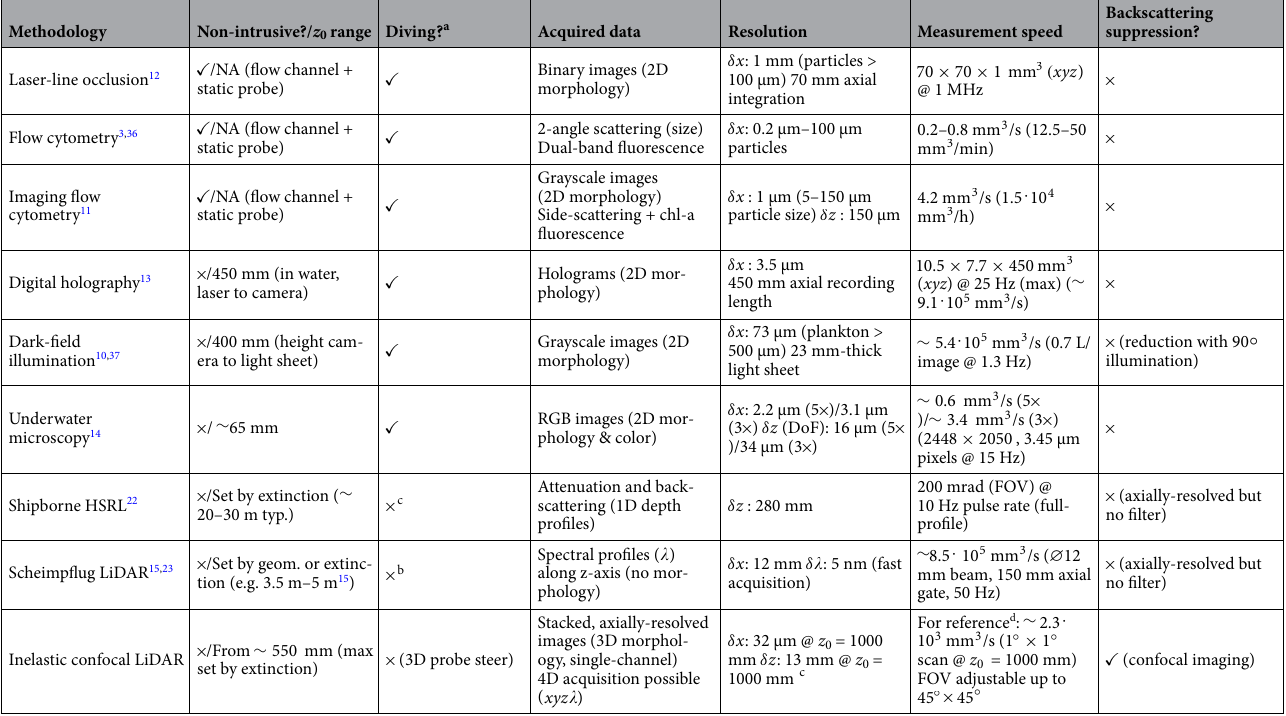
Table 1. Comparison of photonic and optical technologies for in situ plankton detection in several key performance aspects. a The instrument needs a vertical dive (e.g. towed from a ship using a rosette sampler) to obtain depth profiles of plankton distributions. b Can only measure profile along a fixed axis (optical axis, z ). Needs lateral scanning to provide profiles in different transverse coordinates (e.g. relative movement of the ship). c For an 1” objective lens presented herein. Can be enhanced by increasing the exit pupil aperture and decreasing the circular pinhole diameter accordingly. d For a 400 × 400 image resolution acquired at 1 Hz. Speed currently limited by the mechanical scanning unit. The methodologies are considered intrusive if the organisms need to flow through an enclosed probing area inside the instrument in order to be detected. z